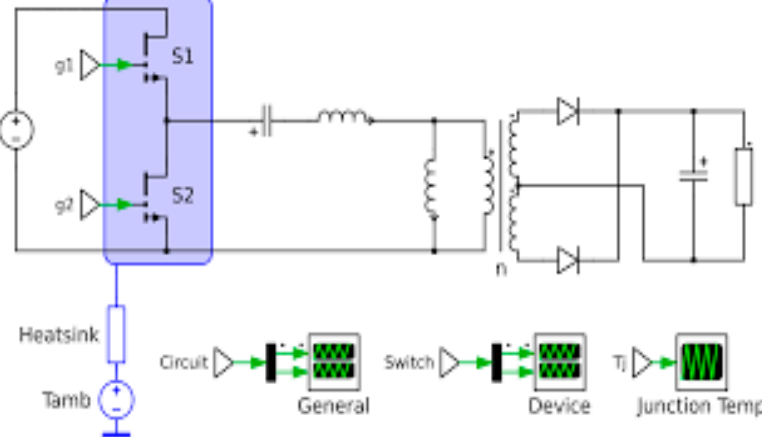
Figure 8. An isolated LLC converter for charging station applications [46].